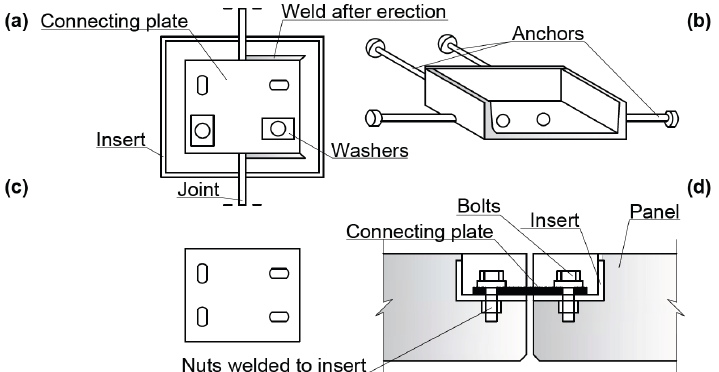
Figure 8. Details of limited wall-to-wall slip bolted joint: ( a ) elevation ( b ) insert ( c ) connecting plate ( d ) section (based on the information provided in [53]) .